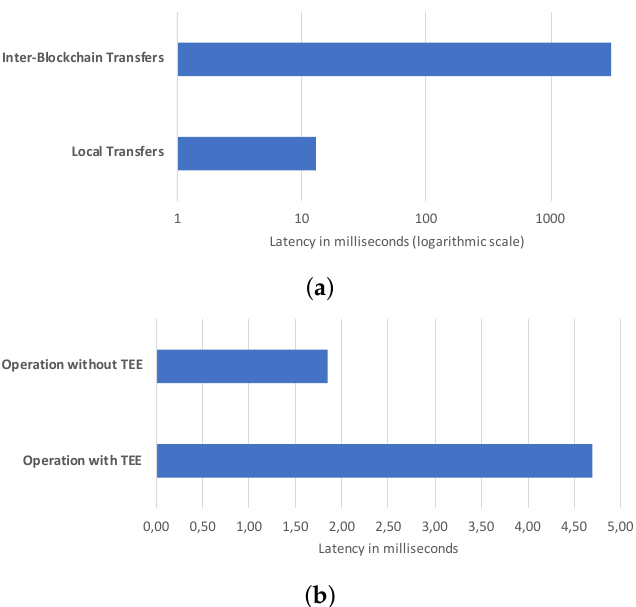
Figure 10. Latency assessment: ( a ) Latency worsening when transferring among blockchains, and ( b ) Latency worsening when using TEE-based